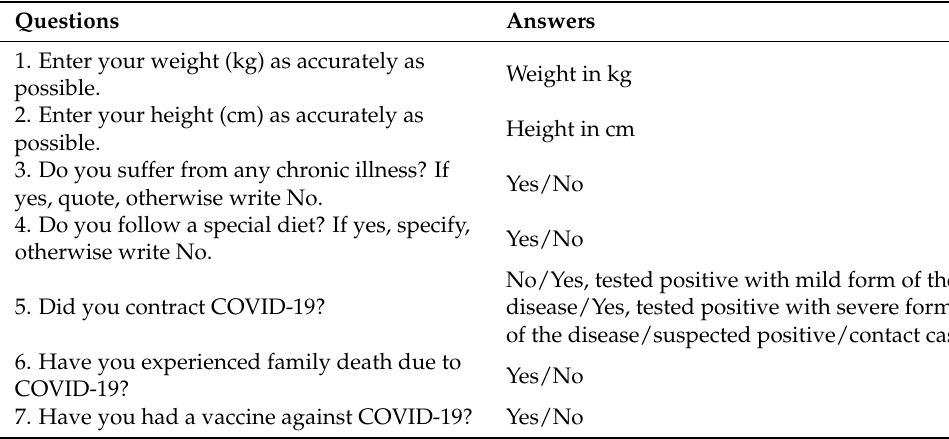
Table A2. Anthropometrics and medical